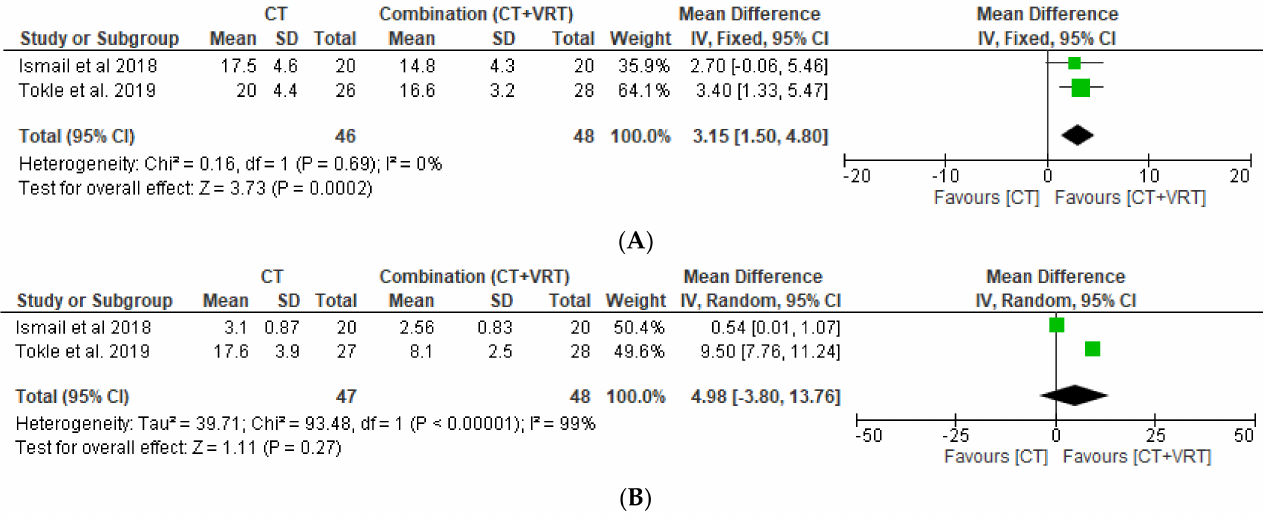
Figure 4. Forest plots of comparison of DHI score at ( A ) 3 months, and ( B ) 12 months in CT and combination groups [14,15].